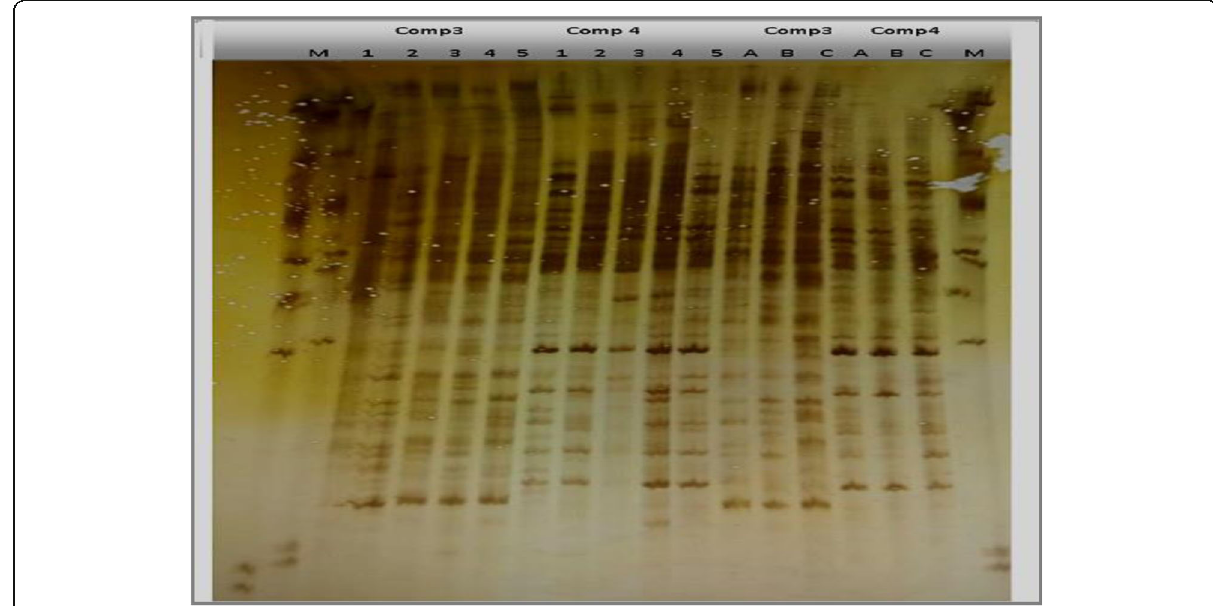
Fig. 2 The AFLP banding patterns of Origanum species (1, O. vulgare ; 2, 3, 4, and 5, O. syriacum ) and Thymus species (A, T. vulgaris ; B, T. capitatus ; and C, T. decassatus ) using two primer combinations (E-AGG/M-CTC and E-ACC/M-CAT). M: 100-bp DNA